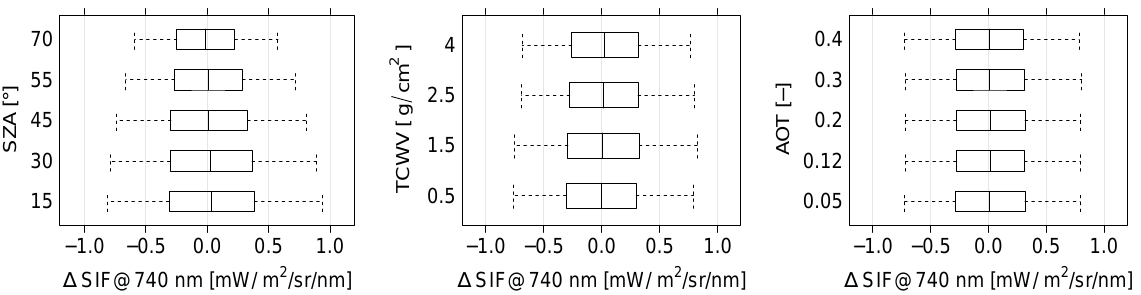
Figure 6. Retrieved minus simulated SIF in dependence on the simulated solar zenith angle (SZA), the water vapor column (TCWV) and aerosol optical thickness at 550nm (AOT) for the same retrieval properties as in Fig. 5 (eight provided PCs, 720–758nm retrieval window). The vertical bar represents the median, the box/error bar covers 50/90% of differences.